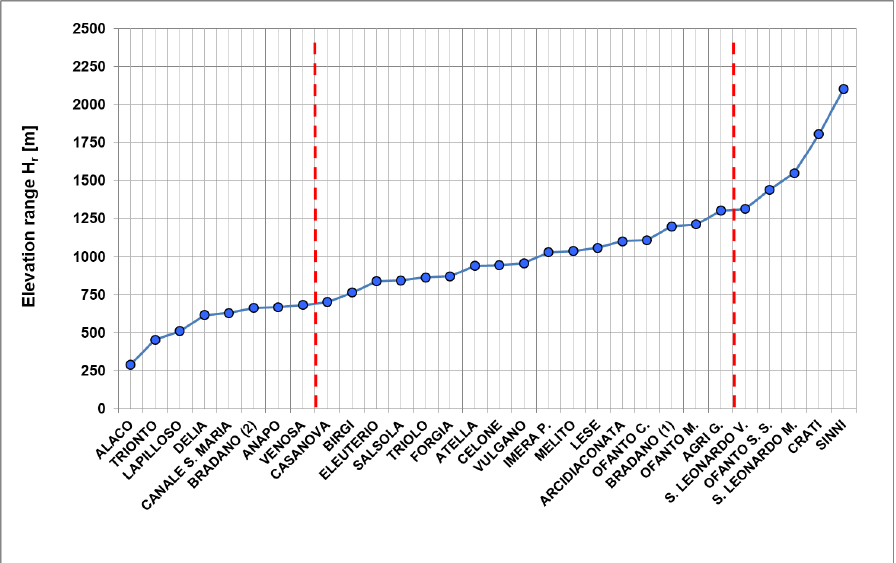
Figure 4. Elevation range ( H r ) data distribution in the selected catchments. The red dashed lines mark the hypothetical partition of catchments in three subgroups.